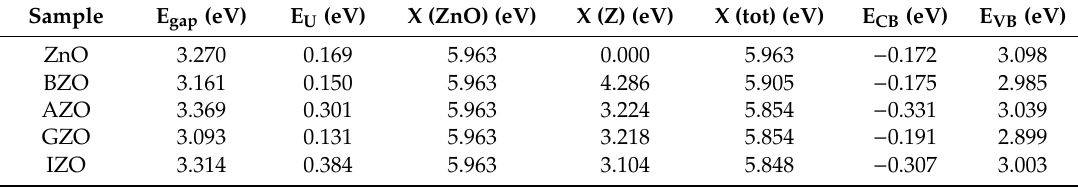
Table 1. The band gap energy E gap , Urbach energy E U , the energy parameter ( X ), and the positions of both the conduction and valence bands of undoped ZnO and group III elements (B, Al, Ga and In)-doped ZnO thin films at a doping level of 3%. BZO, AZO, GZO, and IZO stands for B-doped